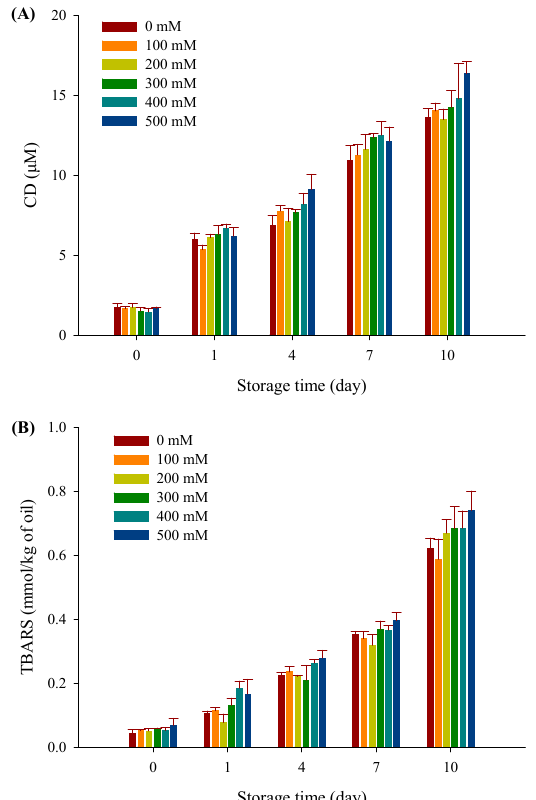
Figure 8. CD values ( A ) and TBARS values ( B ) for filled hydrogels at different NaCl concentrations stored at 37 °C for 10 days.